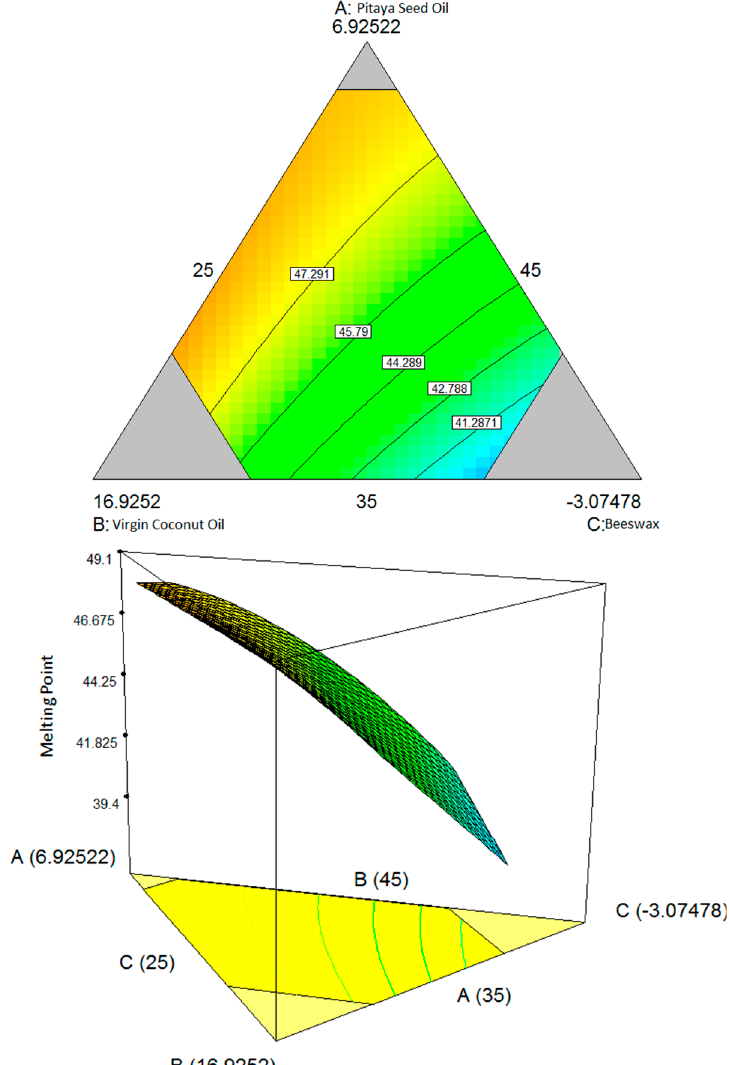
Figure 1. Contour plot (two-dimensional) and three-dimensional surface plots showing the interaction effect between three variables: ( A ) pitaya seed oil, ( B ) virgin coconut oil, ( C ) beeswax; and two variables are kept constant: ( D ) candelilla wax and ( E ) carnauba wax, with respect to the melting